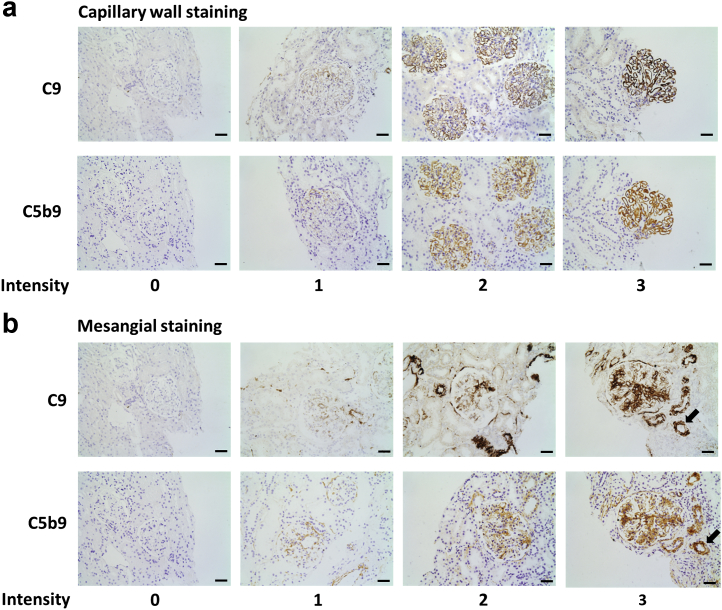
Glomerular immunostaining for complement C9 and C5b-9. Representative images of (a) capillary wall and (b) mesangial staining using antibodies to either C9 or C5b-9. Serial sections from the same biopsy were used. Images depict grade 0, 1, 2, and 3 staining. Staining intensity correlated for each antibody (capillary wall: r = 0.92, P < 0.0001 and mesangium: r = 0.86, P < 0.0001). Arrows indicate vascular staining. Original magnification ×20. Bar = 50 μm. To optimize viewing of this image, please see the online version of this article at www.kidney-international.org.